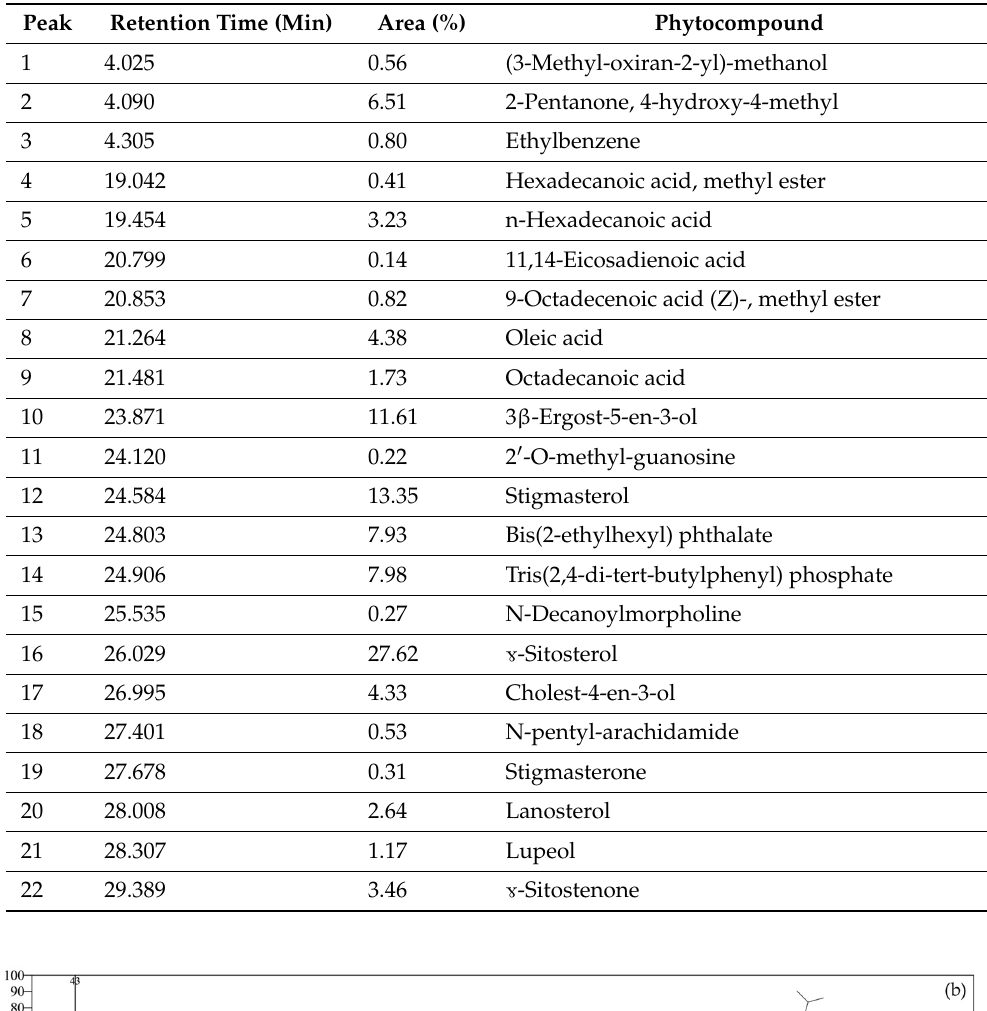
Table 1. GC-MS-based phytochemical profile of ethanolic extract from L. acidissima fruits.